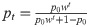
Impact of pre-host evolution on within-host evolution.The blue curve depicts the time course of revertant frequency in competition with vaccine, where the revertant has a 10% fitness advantage and starts at a frequency of 10−6. The curve shows the well-known population genetic principle that, while the favored type (revertant) is rare, its absolute frequency changes very little. But the frequency eventually reaches a level at which evolution is rapid. The yellow box represents a possible period of pre-host evolution, the green box representing the period of within-host evolution. The periods of within-host evolution are drawn to be the same length in right and left panels, as if the vaccine has the same within-host duration in both cases. The arrow represents a possible point at which manufacture would end and an inoculum be created, thus defining the boundary between pre-host and within-host evolution. The left panel depicts a short period of vaccine manufacture, the right a longer period of vaccine manufacture and one in which more pre-host evolution has occurred. It is thus easy to see the potential importance of pre-host vaccine evolution on within-host evolution, for even when the revertant is not a large component of the inoculum, it can be poised for rapid evolution within the host (right panel). The curve obeys pt=p0wtp0wt+1-p0, in which pt represents the revertant frequency in generation t and w the fitness of revertant relative to vaccine. The curve is drawn for a common evolutionary process across pre-host and within-host evolution, but evolution in the within-host phase will typically experience different parameters than evolution in the pre-host phase.